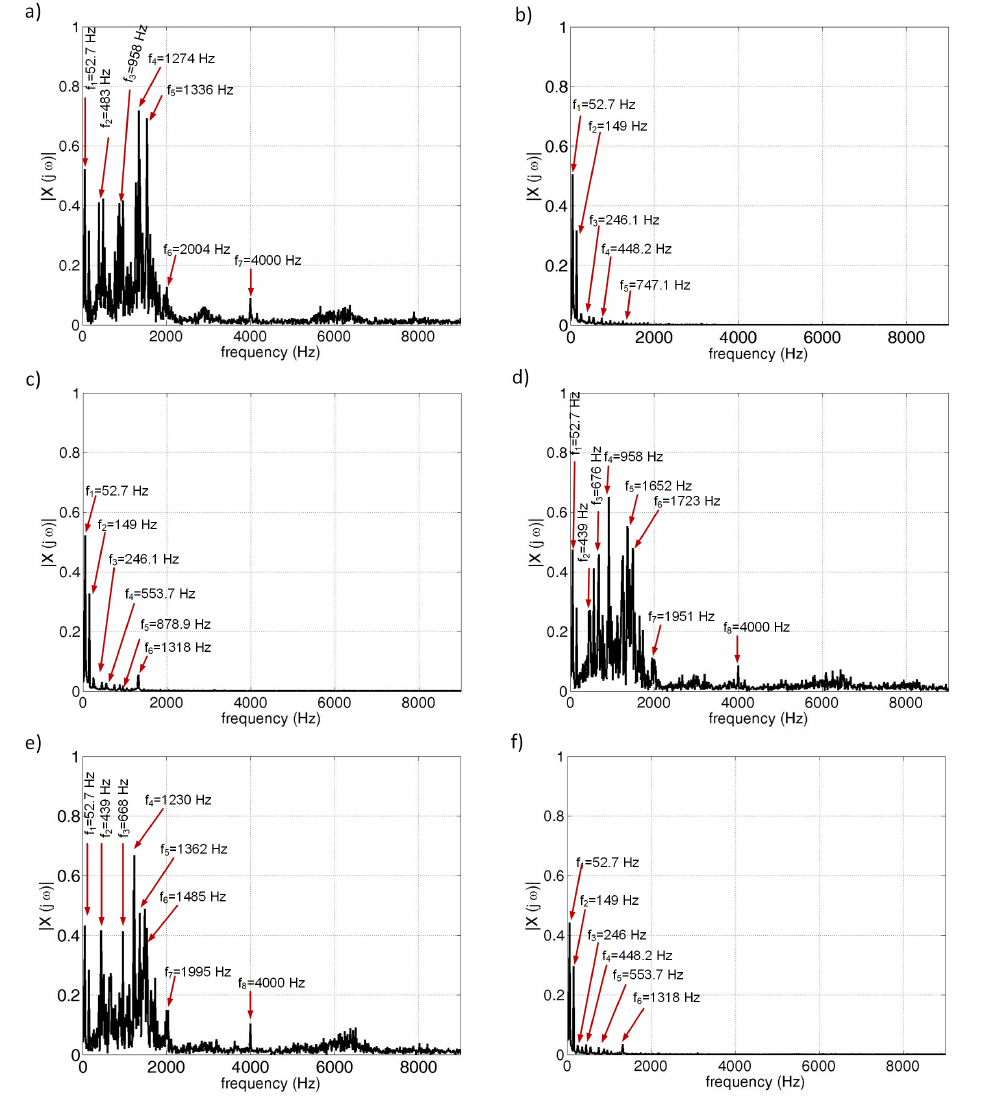
Figure 9. Resulting amplitude spectra for the operating modes I.–VI. (( a ) frequency amplitude spectrum of the motor vibration signal, ( b ) the pump vibration signal, ( c ) the hydro-generator vibration signal, ( d ) the motor and pump vibration signal, ( e ) the motor and hydro-generator vibration signal, ( f ) the pump and hydro-generator vibration